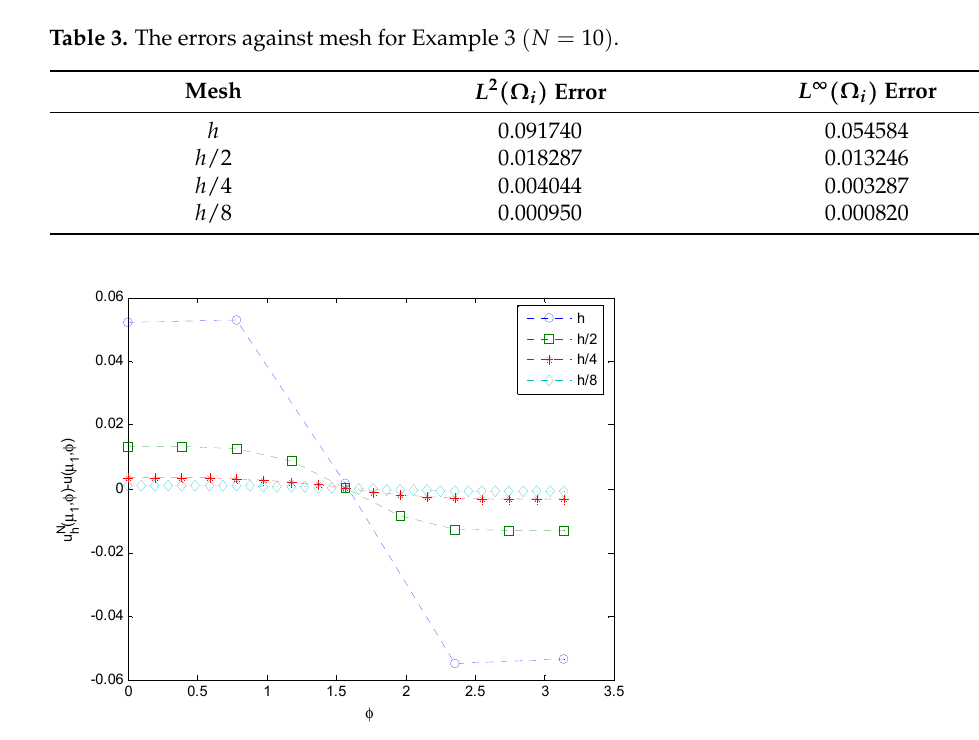
Figure 10. The errors on the artificial boundary against mesh for Example 3 ( 𝑁 = 10) .